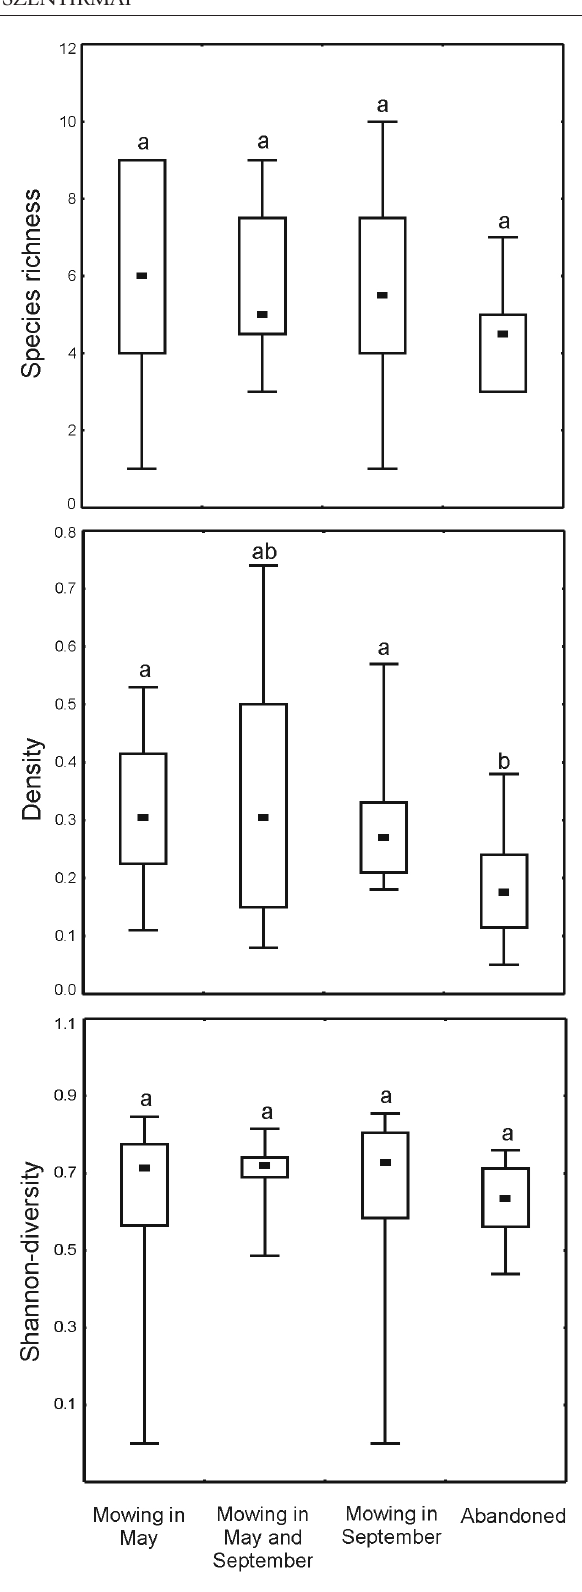
Figure 3. Box-plots (median values with minimum, maximum and ±SE) of species richness, density (specimen/m 2 ) and Shannon diversity of orthopterans in four treatment types of sites I–IV. Sig- nificant (p<0.05) differences detected by Mann-Whitney U test are indicated by different